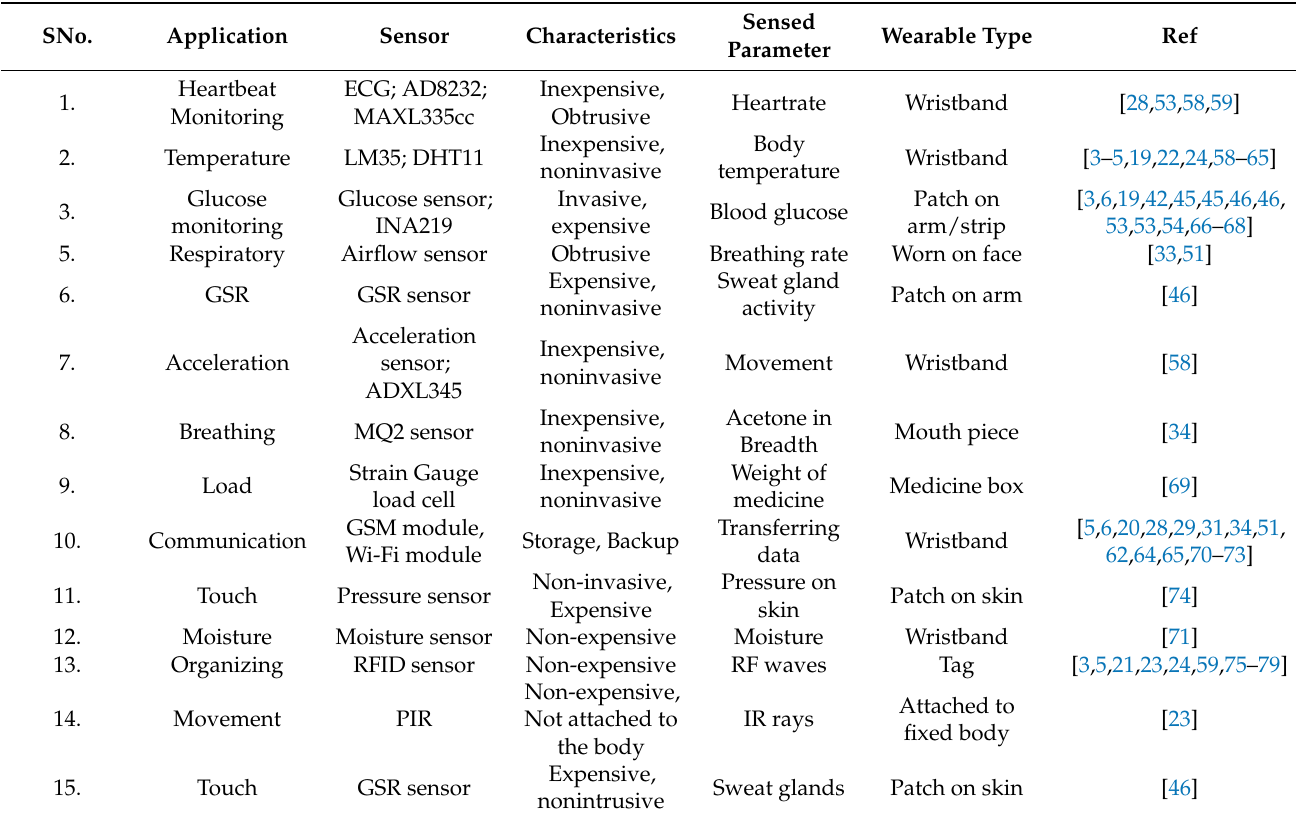
Table 3. Various IoT-assisted Wearable Sensors for Healthcare Monitoring.